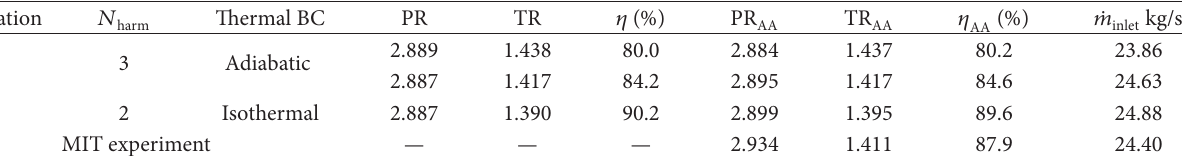
T 4: Experiment and simulation pressure ratio, temperature ratio, adiabatic efficiency, and mass �ow. MIT experiment mass �ow comes from an average across the three windows at the inlet.